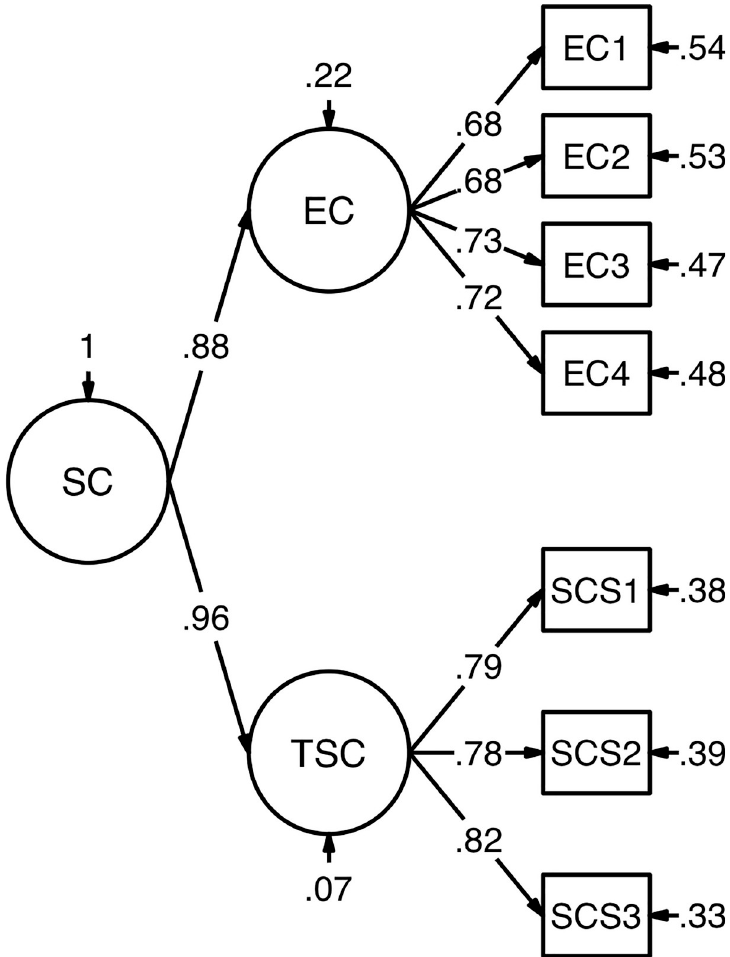
Fig 2. Summary of a second-order factor model of Self-Control. N = 1209. Standardized estimates (estimator = robust maximum likelihood), item parcels as manifest indicator variables (see text for details). Unstandardized loadings of first-order factors were set equal. SC = general Self-Control. EC = Effortful Control. TSC = Trait Self-Control. All paths significant with p < .001.